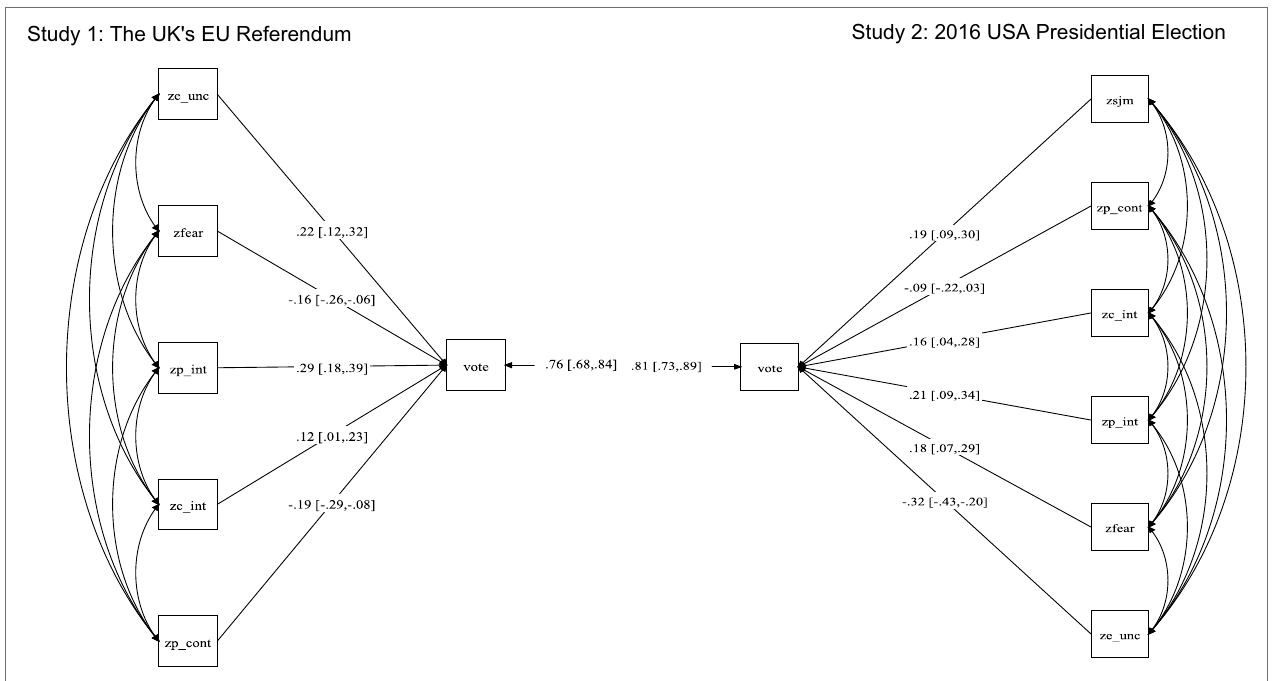
FIGURE A | Logistic regression model with reasons for voting as predictors while reported voting preference (vote) is the outcome. Reported are standardized estimates are presented outside the parentheses, while the 95% CIs are presented within the parentheses. The analyses (and figures) were generated in Mplus version 7 (using maximum likelihood estimation). Variable Key: zc_unc = uncertainty; zfear = fear; zp_int = personal interests; zc_int = collective interest; zp_cont = need to maintain control; zsjm = system justification